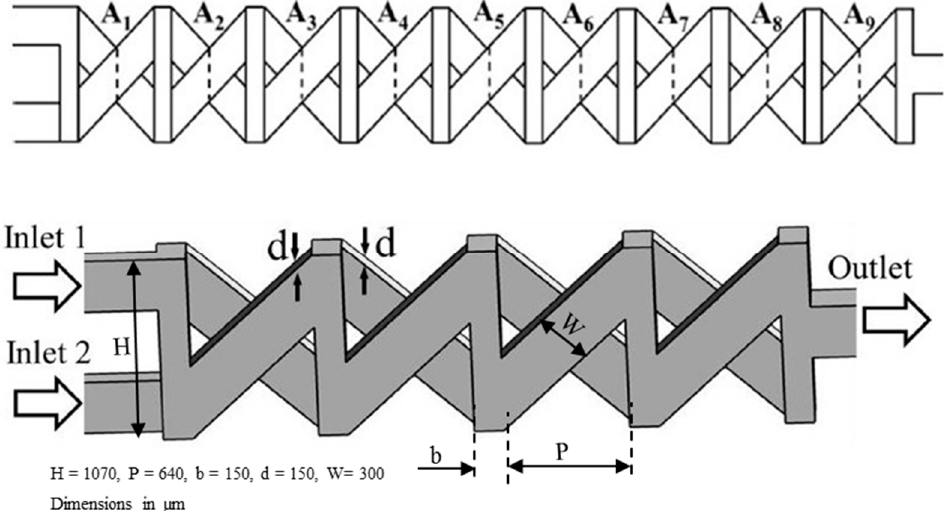
Figure 9. Chaotic micromixer with two-layer crossing microchannels: M-9 (no. of mixing units used: 8). Reproduced with permission from [89].